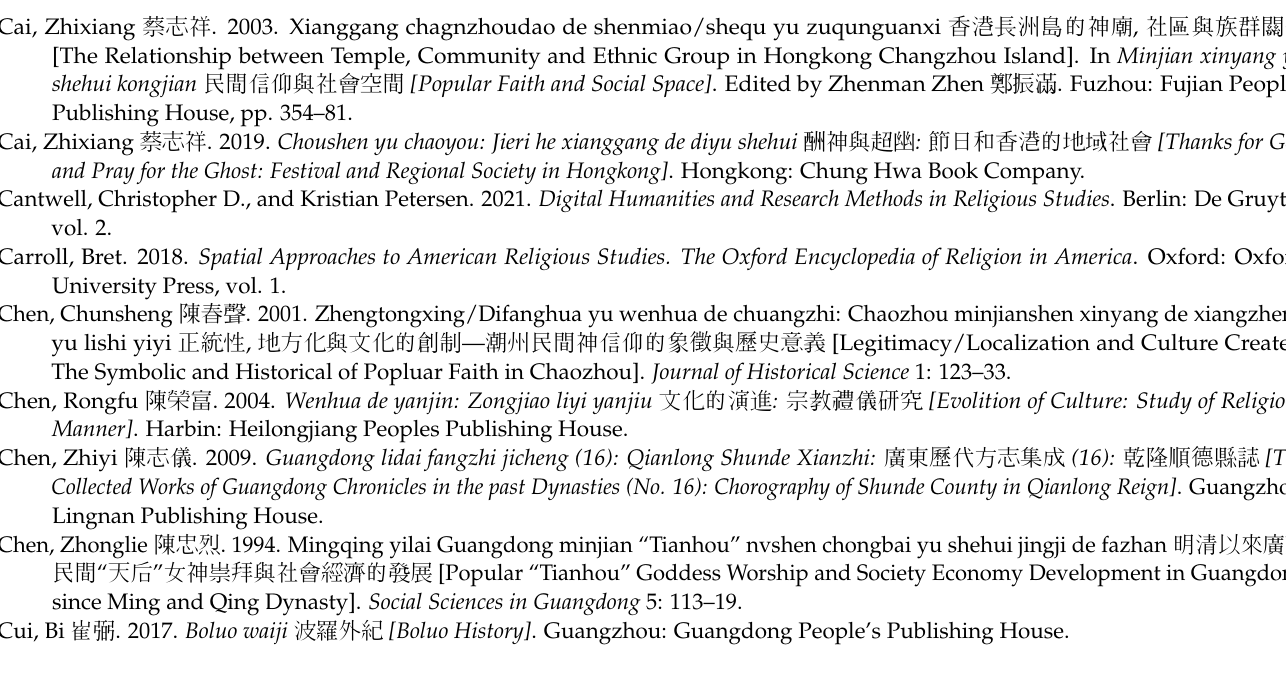
Illustrate: left picture authorized with Chinese standard map service system, drawing No. GS (2016)1554, more detail on “Copyright and Licensing” are available via the following link: http://bzdt.ch.mnr.gov.cn/ (accessed on 2 August 2022); Right picture redraws from (Li 1991, pp. 73–78). Apart from mentioning book titles and the city nowadays, this paper will use Canton instead of Guangzhou as the city’s name. Illustrate: the coastline of the PRD was continuously silted up in the historical period. Figures 3–6, coastline morphology at different times is drawn based on historical maps. Before Qing Dynasty (<1643) is based on (Tan 1982a, pp. 72–73); Early Qing Dynasty (1644–1722) is based on (Wang 2007), No. 1000000038; Middle Qing Dynasty (1723–1850) is based on (Tan 1982b, pp. 44–45); Late Qing and early Republican China (1851–1920) is based on (Zhang 2009, p. 12). These maps are published in the authoritative department in China, which have been studied abundantly, and their accuracy has been guaranteed to a certain extent. They are used as spatial references for visual reconstruction in this paper. All maps in this paper have been modified by